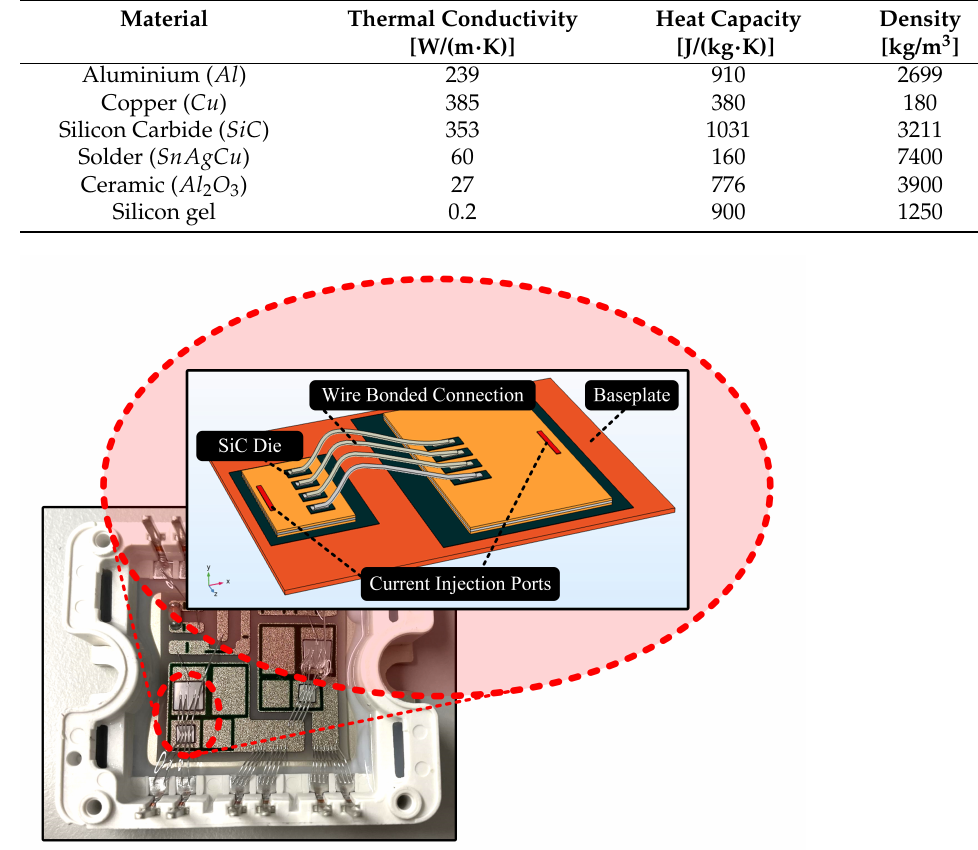
Table 1. Material specifications in the developed FEM model of SiC MOSFET power module.